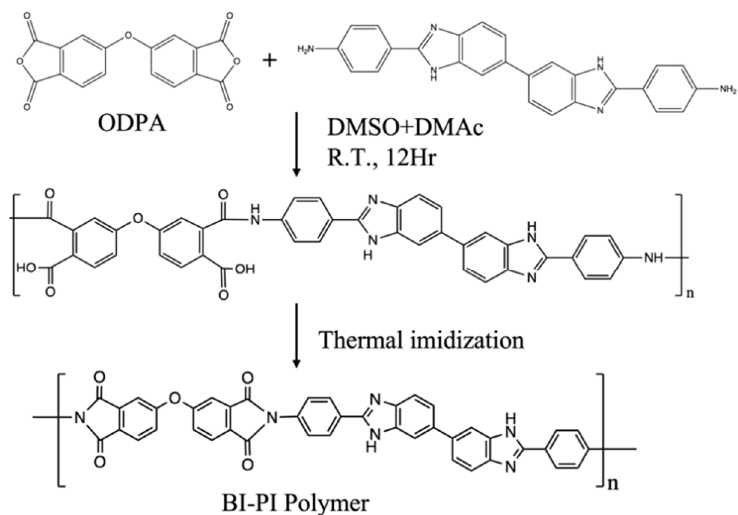
Figure 2. Schematic diagram of BI-PI preparation.